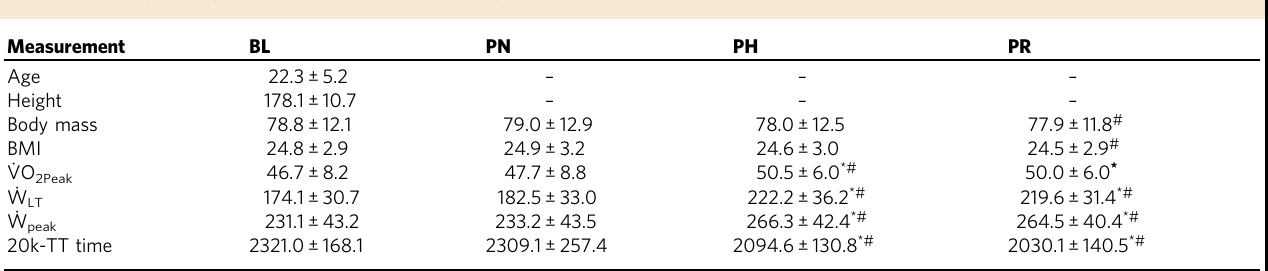
Table 1 Participants ’ physiological and endurance performance